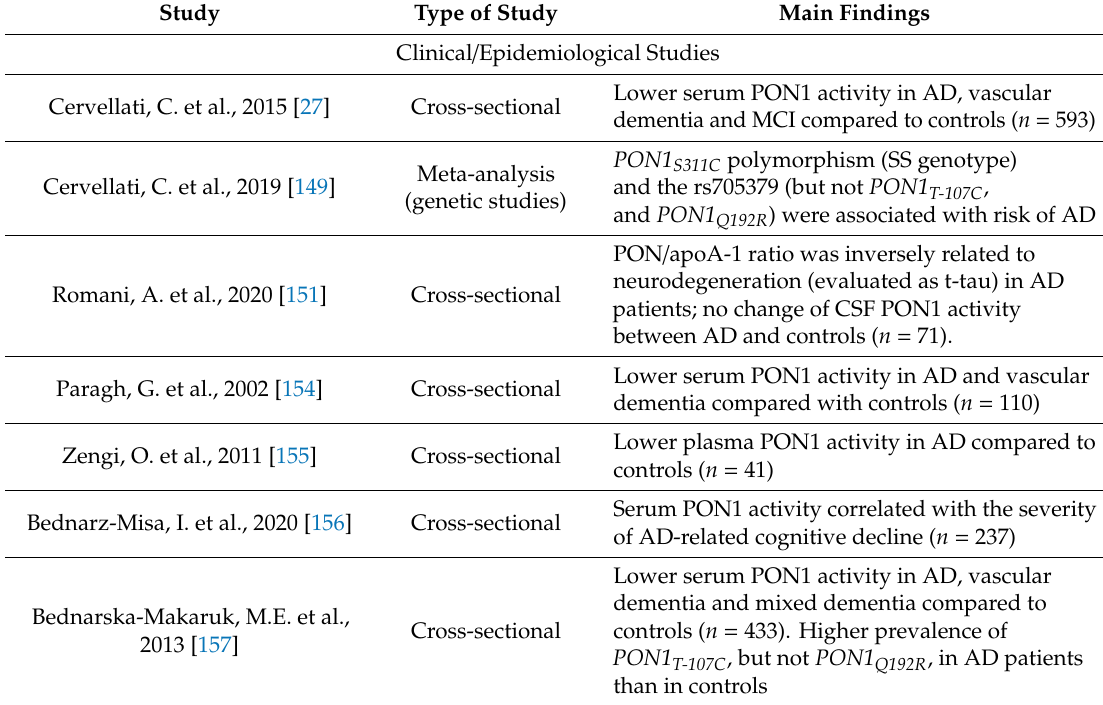
Table 4. Selection of preclinical and clinical evidence supporting the role of paraoxonase 1 (PON1) in protecting from Alzheimer’s disease